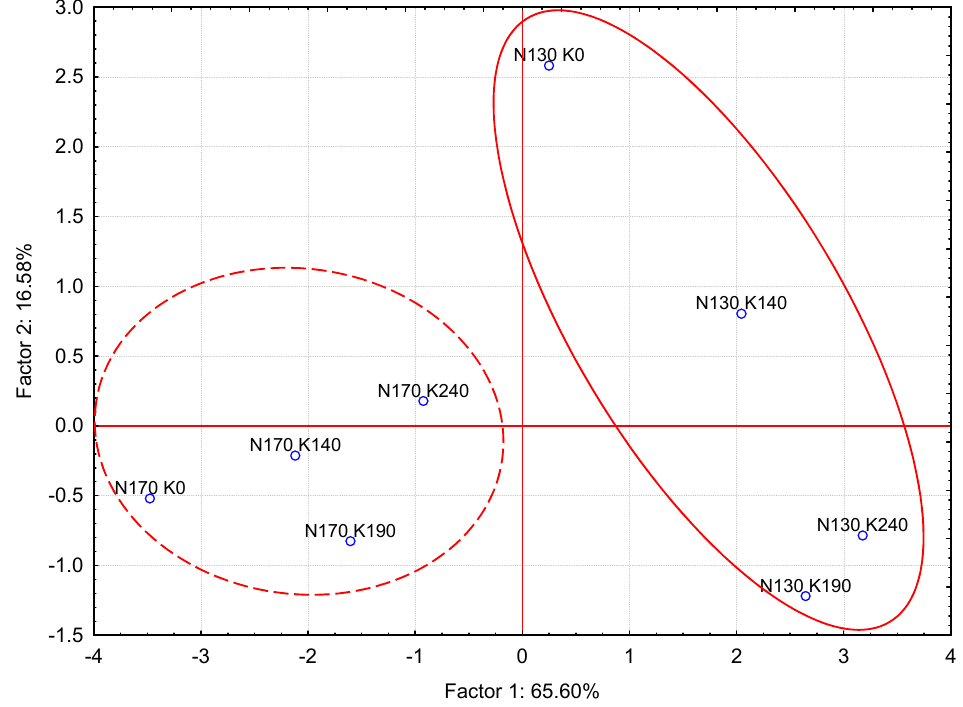
Figure 2. Effect of N and K fertilization on content of trace elements in soil illustrated with the PCA method. Key: points show soil samples with trace elements (N 130—130 mg N/kg, N 170—170 mg N/kg; K0—0 mg K/kg, K140—140 mg K/kg, K190—190 mg K/kg, K240—240 mg/kg of soil).